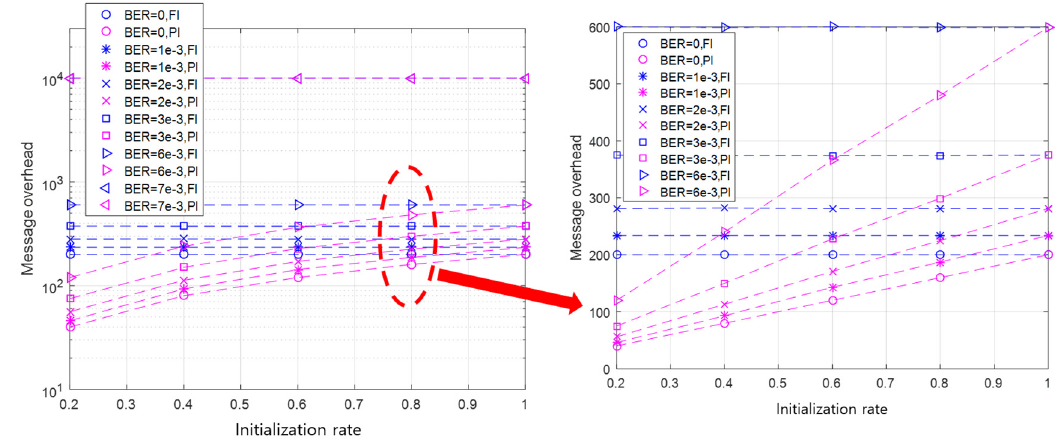
Figure 10. The message overhead of the API and FI according to BER and the initialization rate.